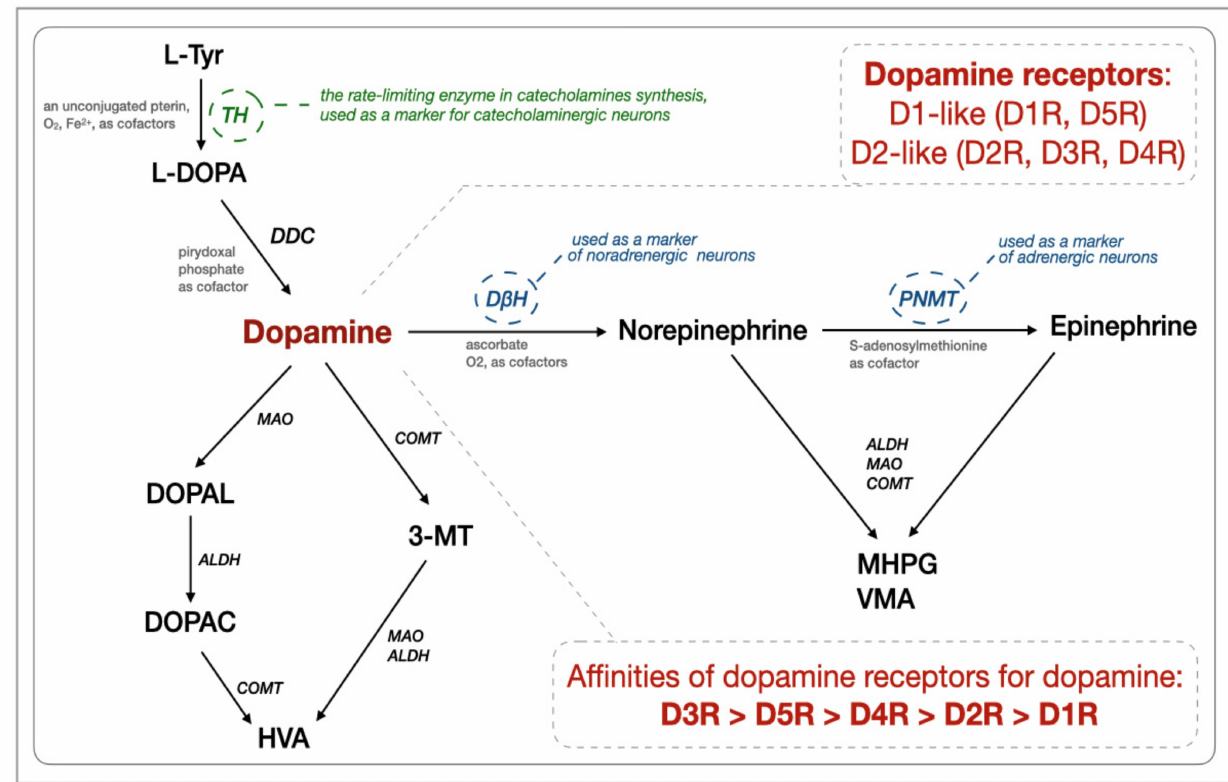
Figure 1. Biosynthesis and degradation of catecholamines together with dopamine receptors (based on [16,23]).